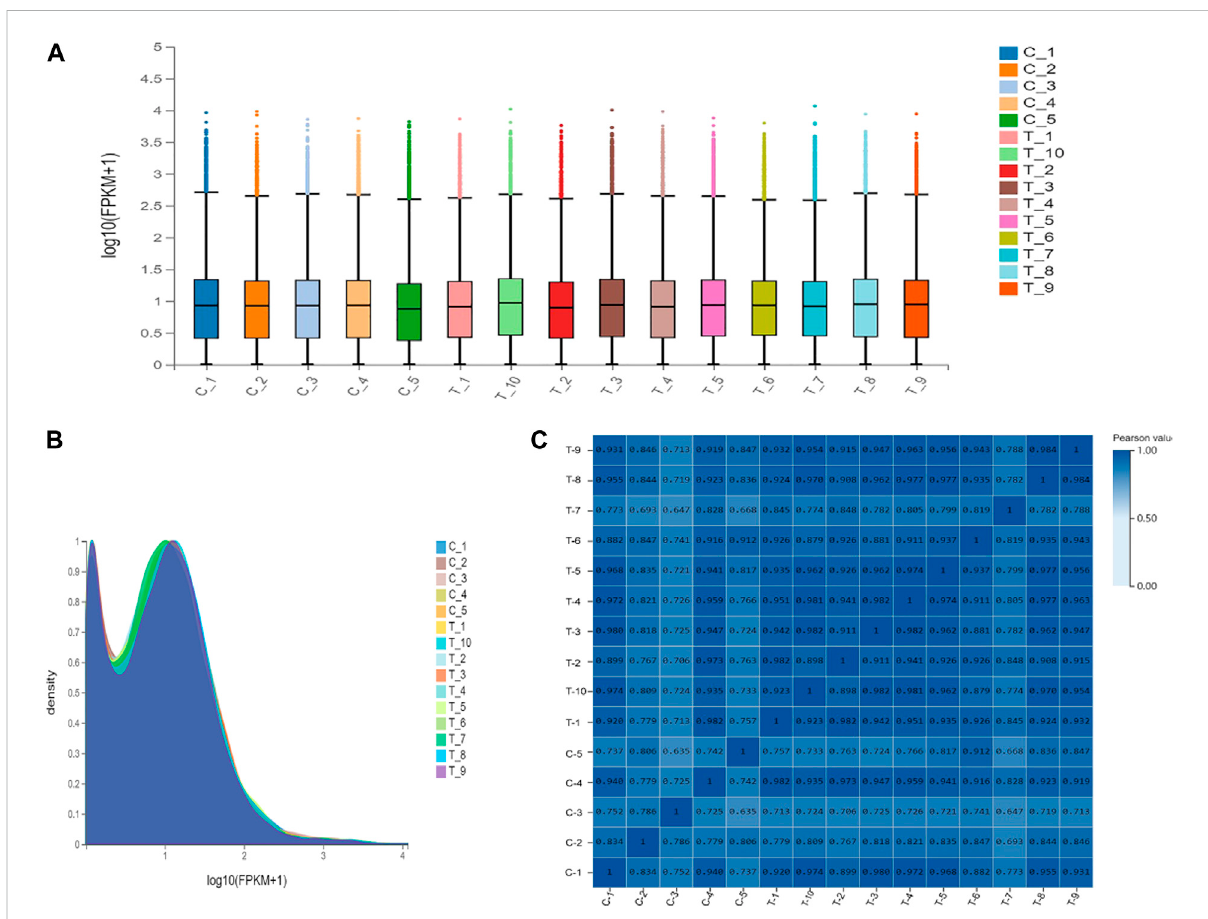
Geneexpressionlevels inthecontrolgroupandtheexperimentalgroup. (A) .Expresstheboxplot. The X -axisisthesamplename,andthe Y -axis is log10(FPKM+1). The boxplot of each region corresponds to fi ve statistics (upper limit, upper quartile, median, lower quartile, and lower limit from top to bottom, where the upper limit and lower limit do not consider outliers). (B) . Gene density map. The X -axis is log10(FPKM+1), and the Y -axis is the gene density, that is, the ratio of the number of genes under this expression level to the total number of expressed genes. (C) . Sample correlation heat map. The X and Y axes represent each sample. The color represents the correlation coef fi cient (the darker the color, the higher the